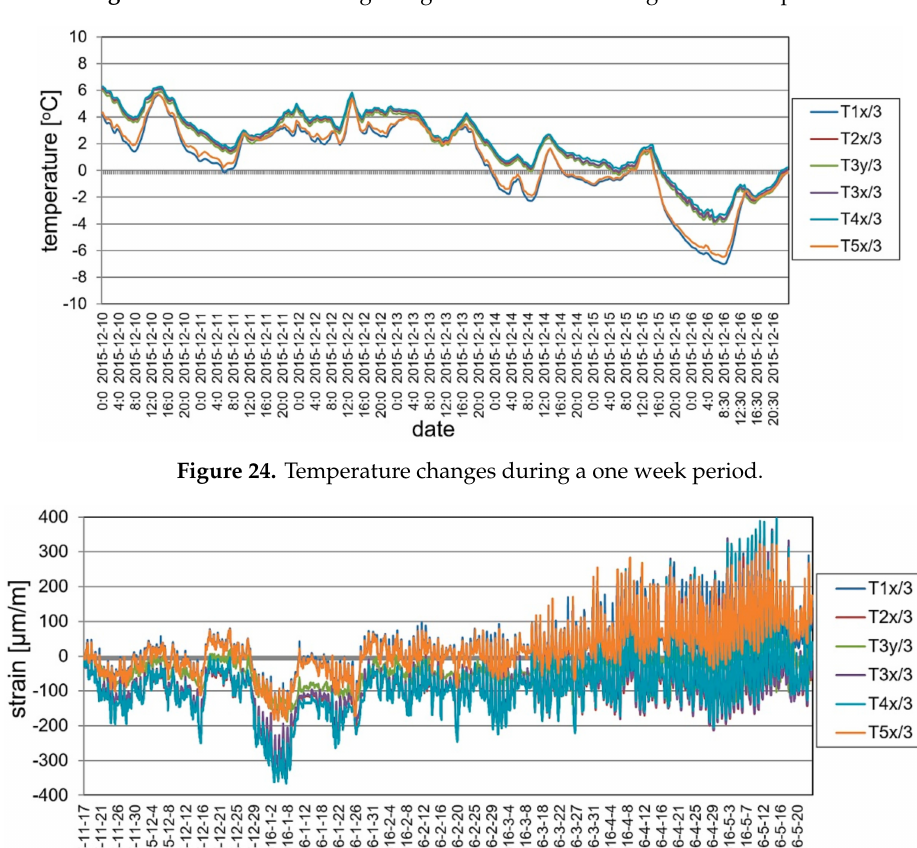
Figure 23. Strain monitoring using VWSG sensors during a one week period.